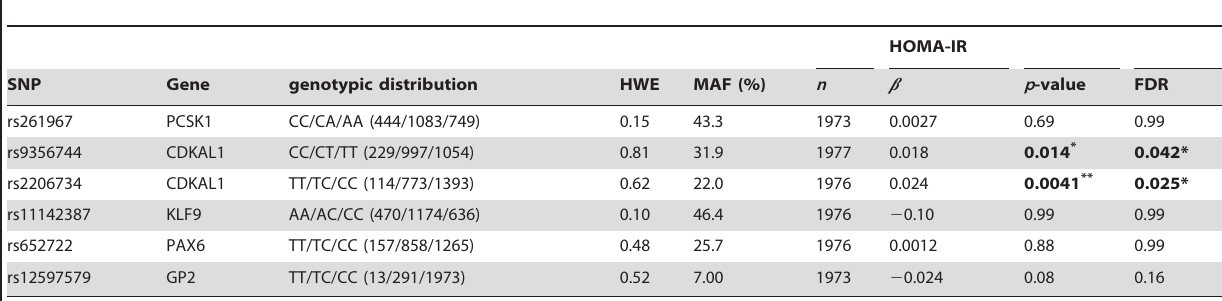
Table 2. Association of SNPs with HOMA-IR in the Greek